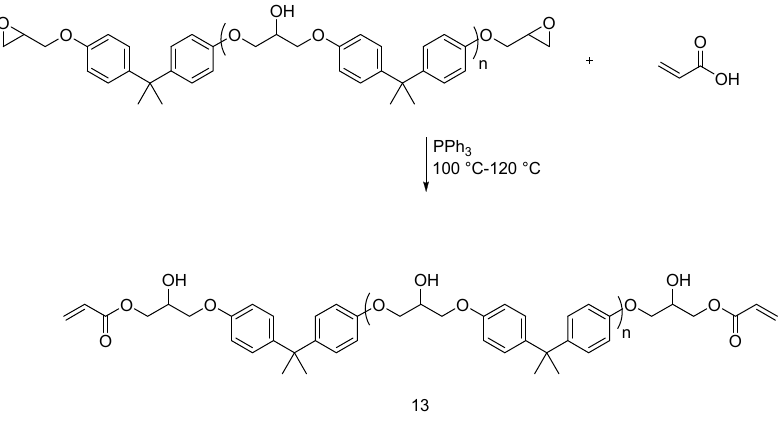
Figure 9. Schematic synthesis of oligomer ( 13 ).